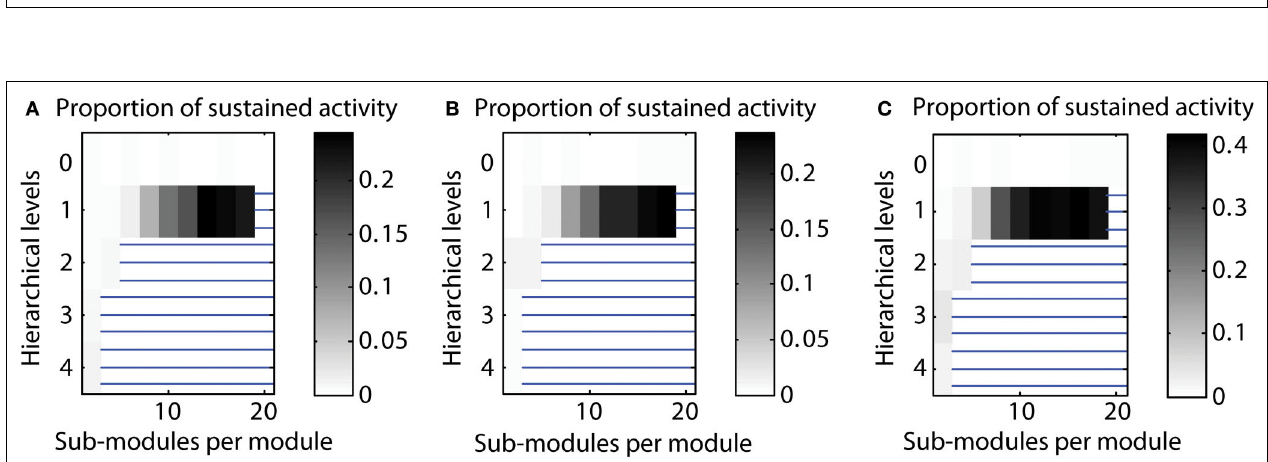
= const.). (C) Increasing number of edges for higher hierarchical levels [ E i